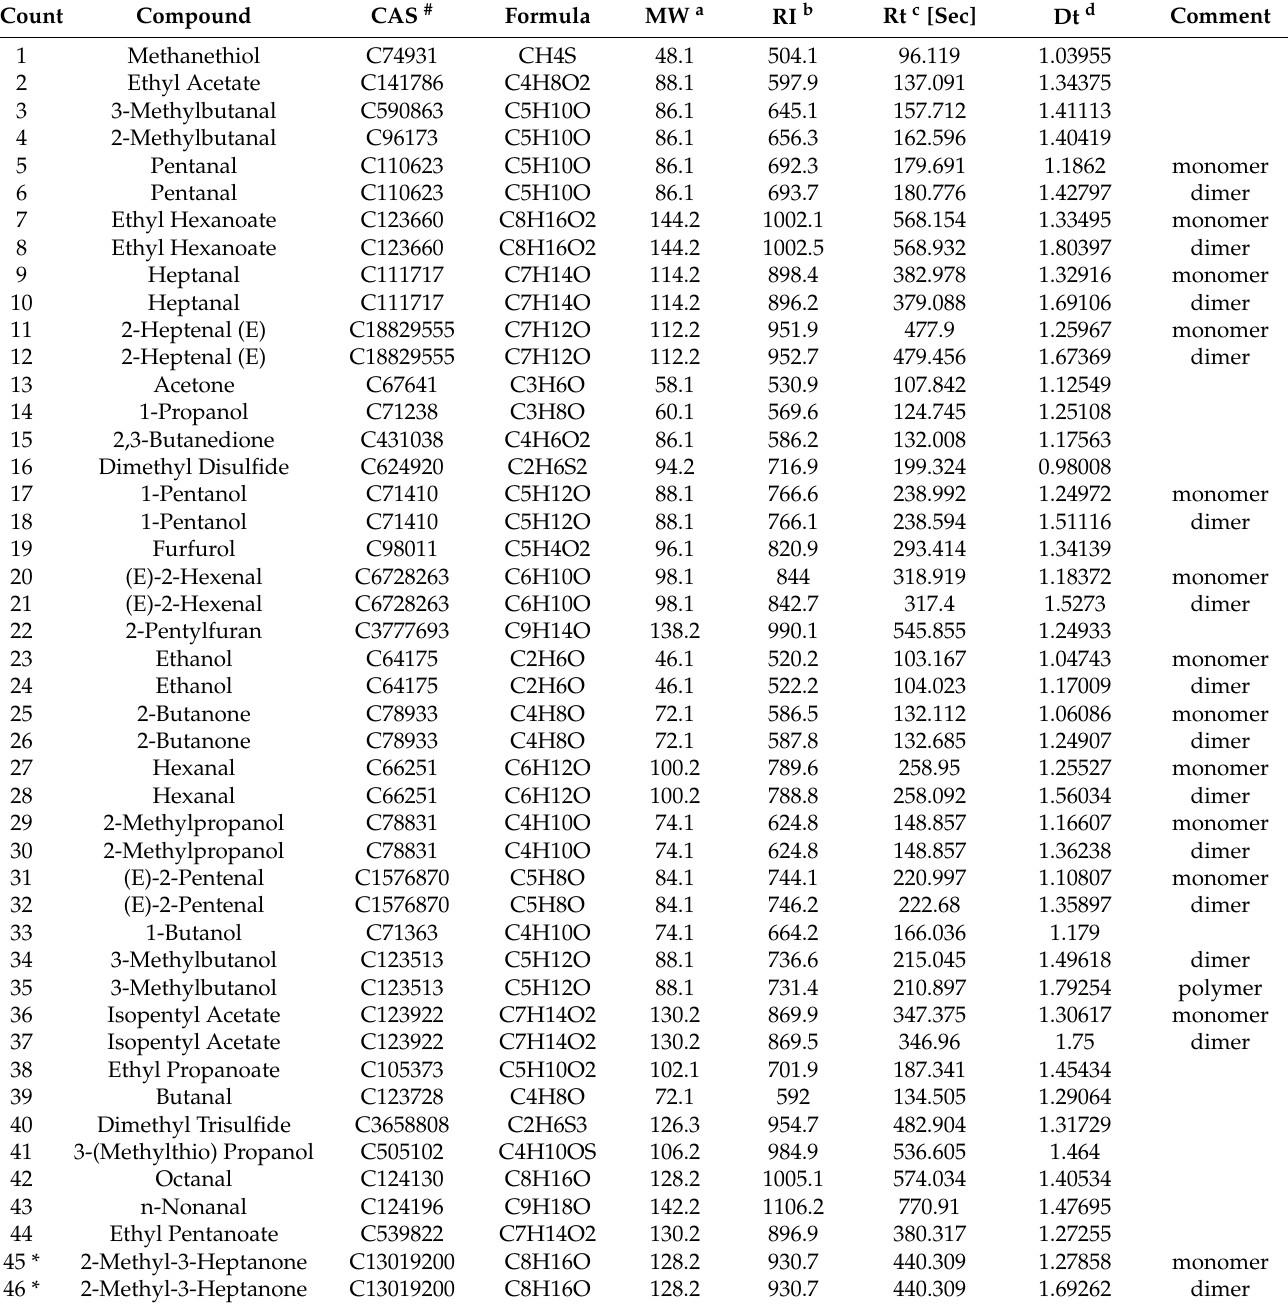
Table 1. The information on detected VOCs of Zhenba bacon by